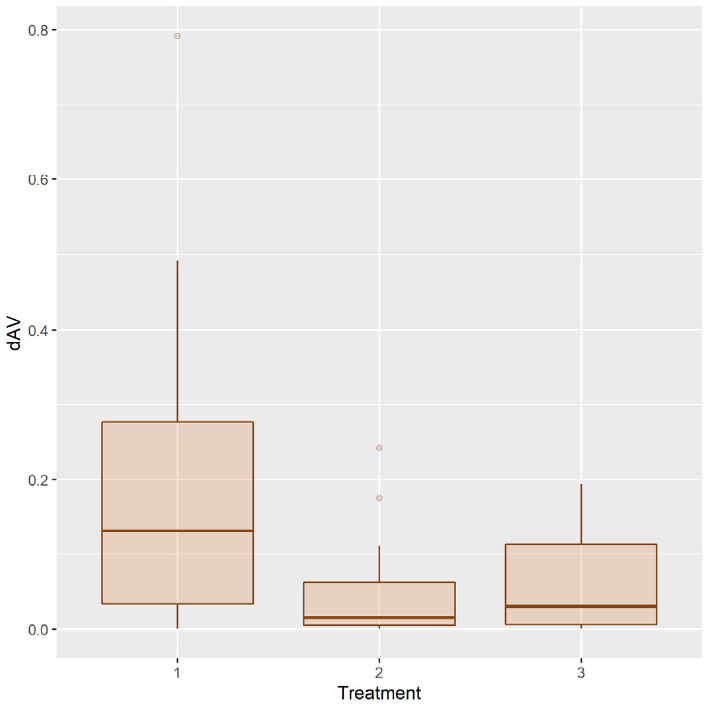
Figure 8. Distribution of the relative residual adhesive volume after treatments 1, 2, 3. Power function transformation was used also to achieve normality of distribution ( p = 0.273, 0.306, 0.053 in groups 1, 2, 3,